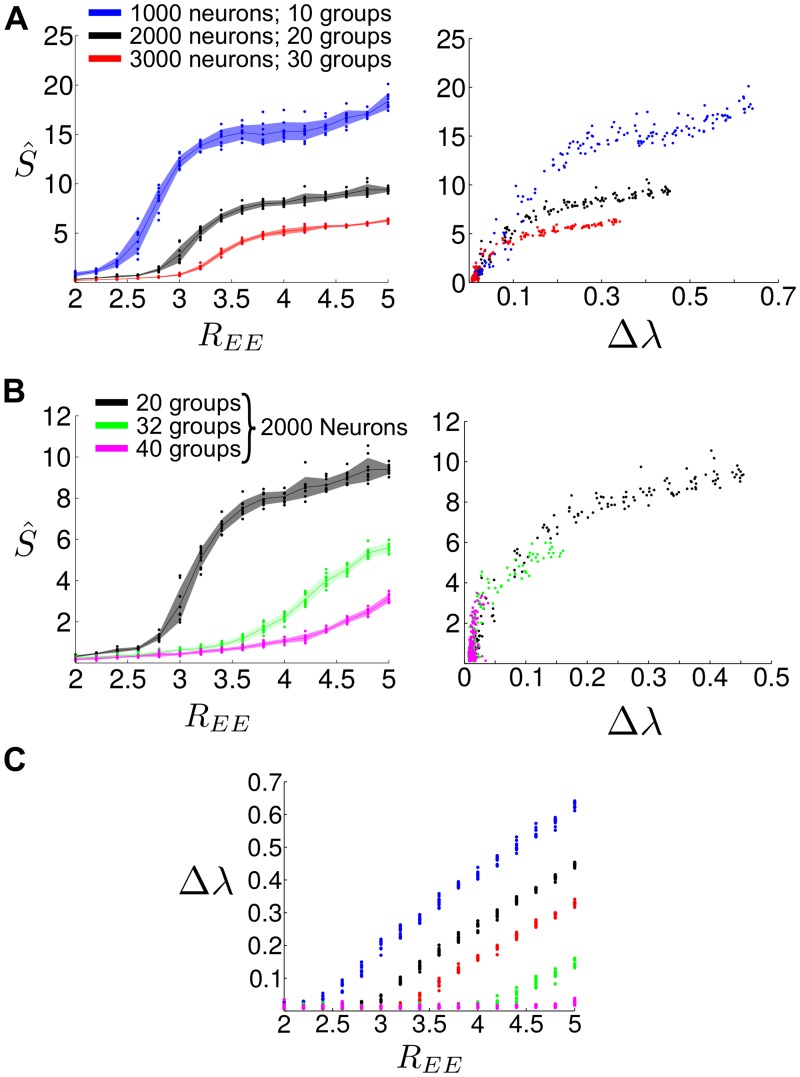
The relationship of observed SSA dynamics with the structural connectivity clustering of the LIF network, R
EE, and the spectral gap, Δλ.The presence of SSA dynamics is quantified through the spike-rate variability metric (S^), which measures the variance of the firing rates of the assemblies normalized by a randomly shuffled bootstrap: S^ increases with increasing SSA activity and S^≈0 for completely asynchronous activity (as in the unclustered case in Fig 1A) (see Materials and Methods). A Spike-rate variability is plotted as a function of R
EE (left) and Δλ (right) for different network sizes (dots: raw data from simulations; line: mean; shading: standard deviation). Above a certain clustering threshold, SSA emerges and increases as R
EE grows; the intensity of the SSA dynamics is in line with the presence of an eigenvalue gap Δλ in the weight matrix. B Spike-rate variability as a function of R
EE (left) and Δλ (right) for a network of 2000 neurons with different numbers of clusters, yielding qualitatively similar results (dots: raw data from simulations; line: mean; shading: standard deviation). C Relationship between the clustering strength R
EE and the spectral gap Δλ. Observe that R
EE is not sufficient to determine Δλ, i.e. Δλ is influenced by other aspects such as the network size and number of groups.